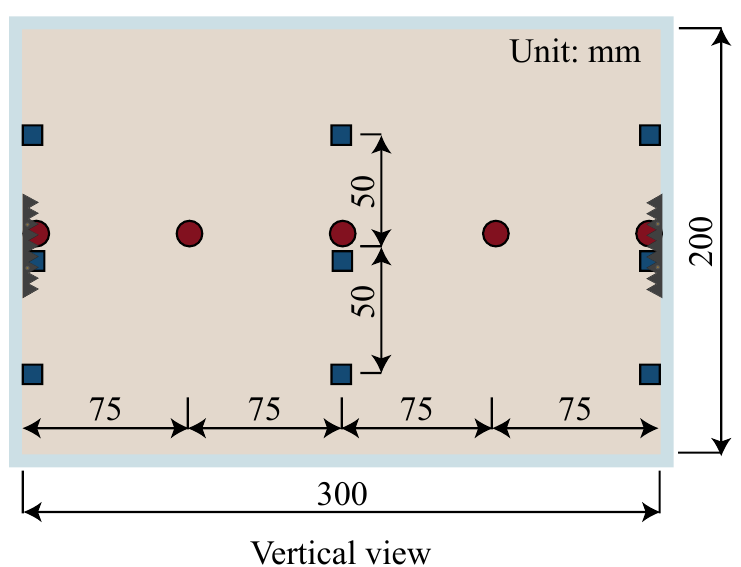
Figure 3. Measuring points